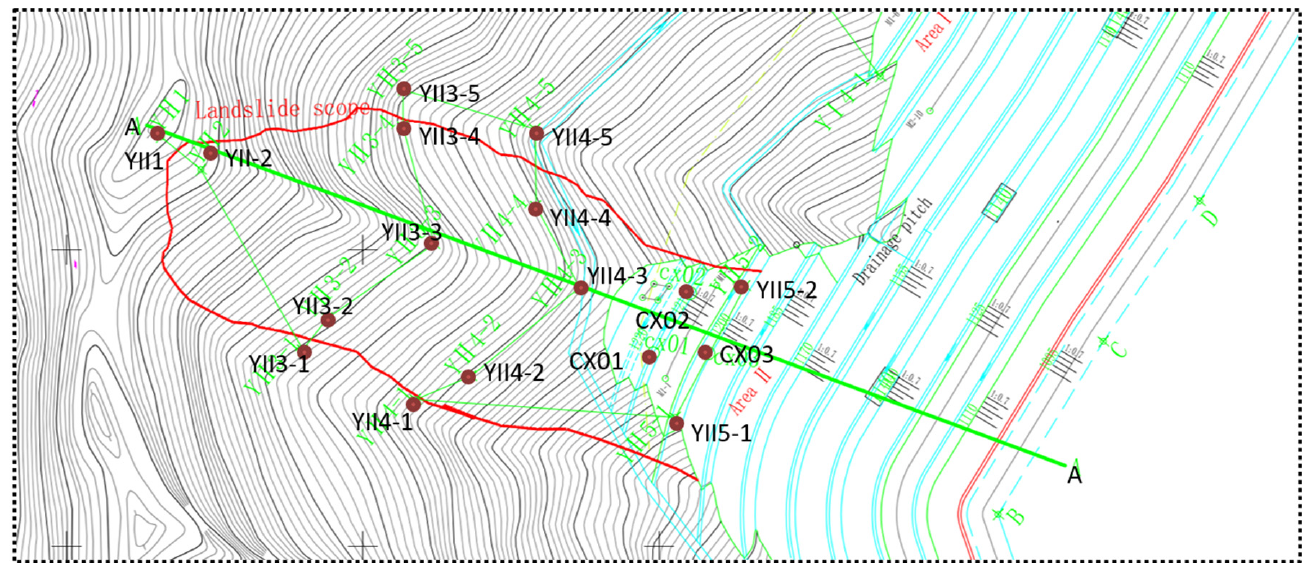
Figure 3. Among them, the positive direction of X points to the north, the positive direction of Y points to the east, and the positive direction of H is vertical subsidence. Monitoring began in early April, 2018. As of 20 June 2021, 352 periods had been observed. Fixed borehole inclinometers were installed in the three boreholes. In August 2018, three 25-m inclinometer holes (CX01, CX02, and CX03) were installed at the front edge of the landslide excavated slope at elevations of 1215, 1215, and 1200 m, respectively.